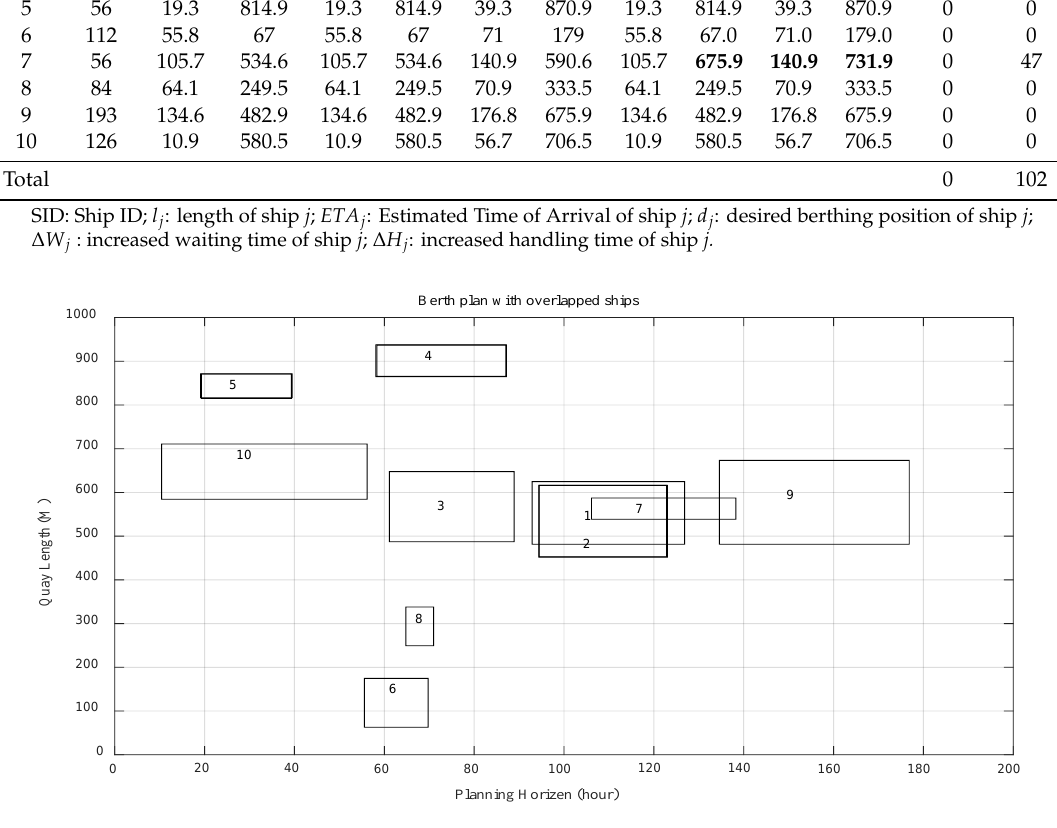
Figure 11. The berth plan with overlapped ships ( N = 10 ships).